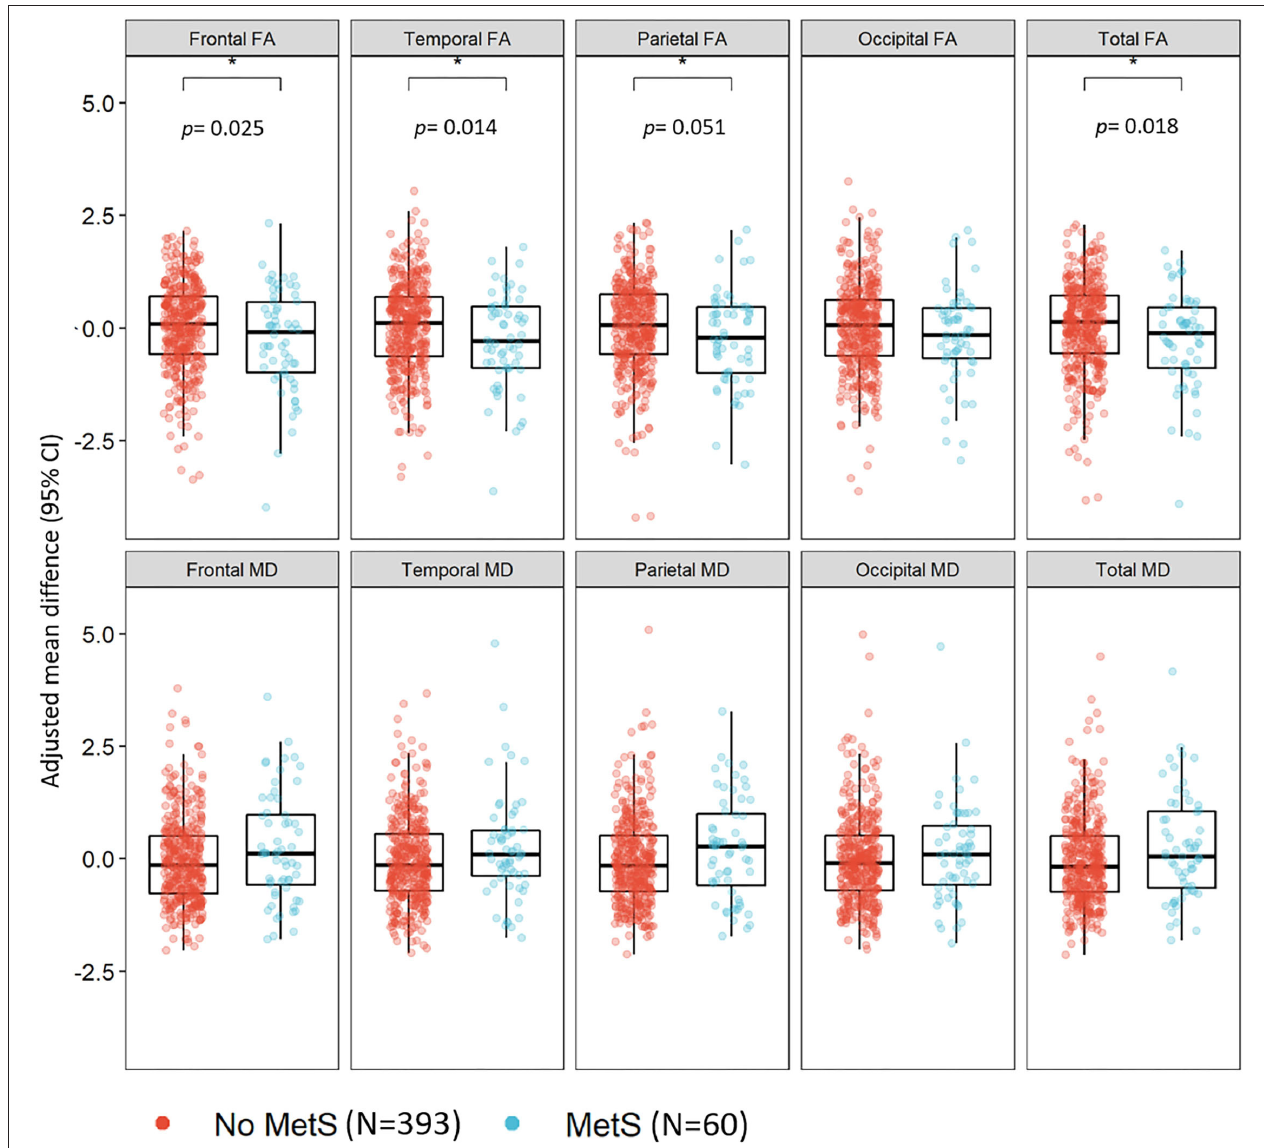
FIGURE 1 | The association between the metabolic syndrome and white matter integrity in midlife among 453 CARDIA participants. CARDIA, Coronary Artery Risk Development in Young Adults; CI, confidence interval; FA, fractional anisotropy; MD, mean diffusivity; MetS, metabolic syndrome. Models adjusted for age, sex, education, race, and scanning